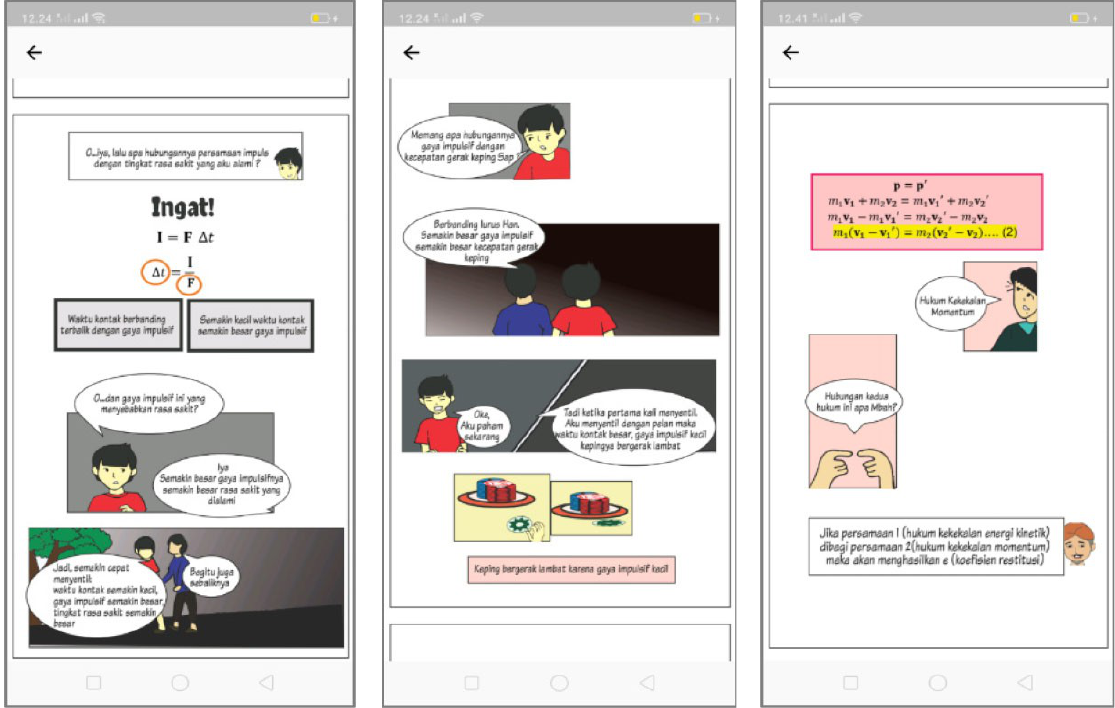
Figure 5. The comic containing indicators of critical thinking and mathematical representation abilities